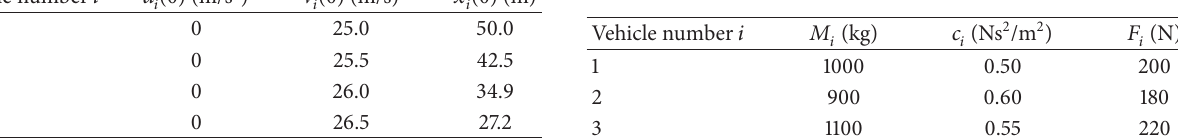
Figure 5: Control input curves of vehicles. Table 2: Parameters of